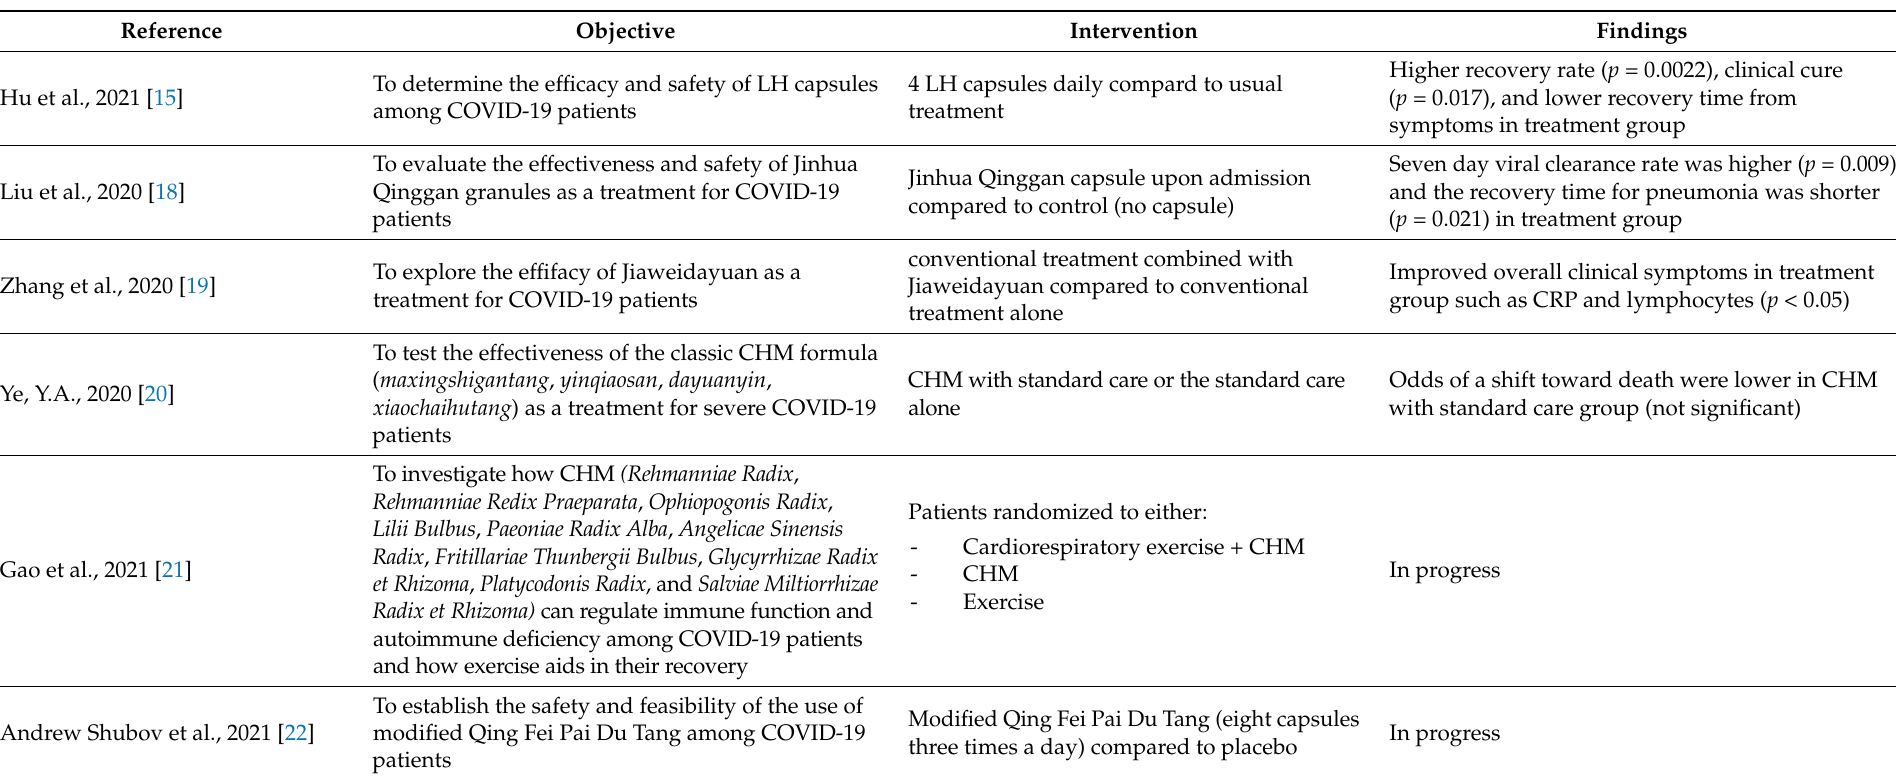
Table 1. Completed and planned clinical trials on the effects of Chinese herbal medicine (CHM) in patients with